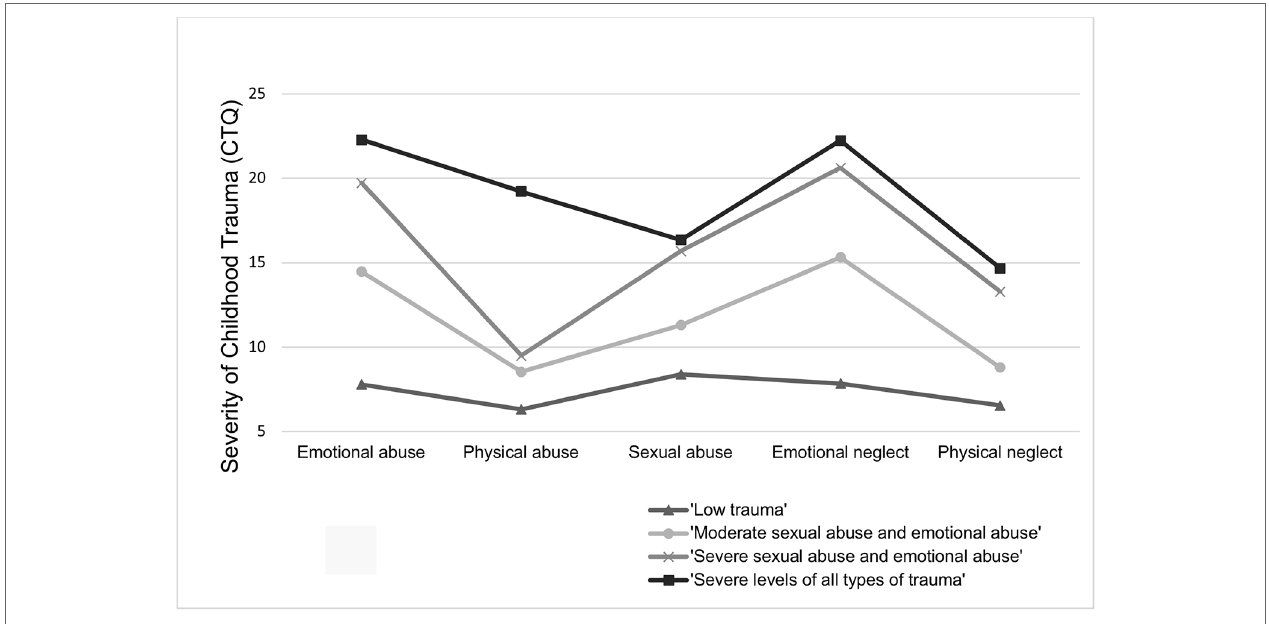
FIGURE 1 | Profiles of childhood trauma in women with substance use disorders and posttraumatic stress disorders. CTQ, Childhood Trauma